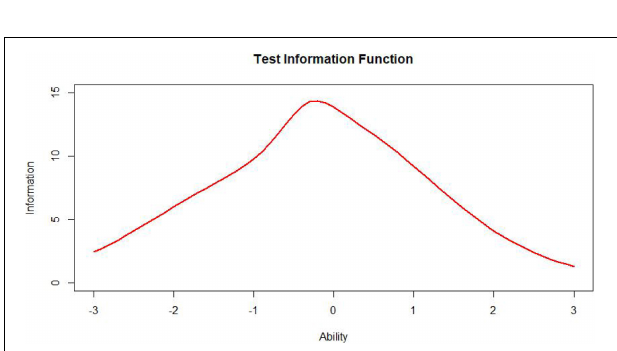
FIGURE 7 | Unimodally distributed test, information, function (TIF).